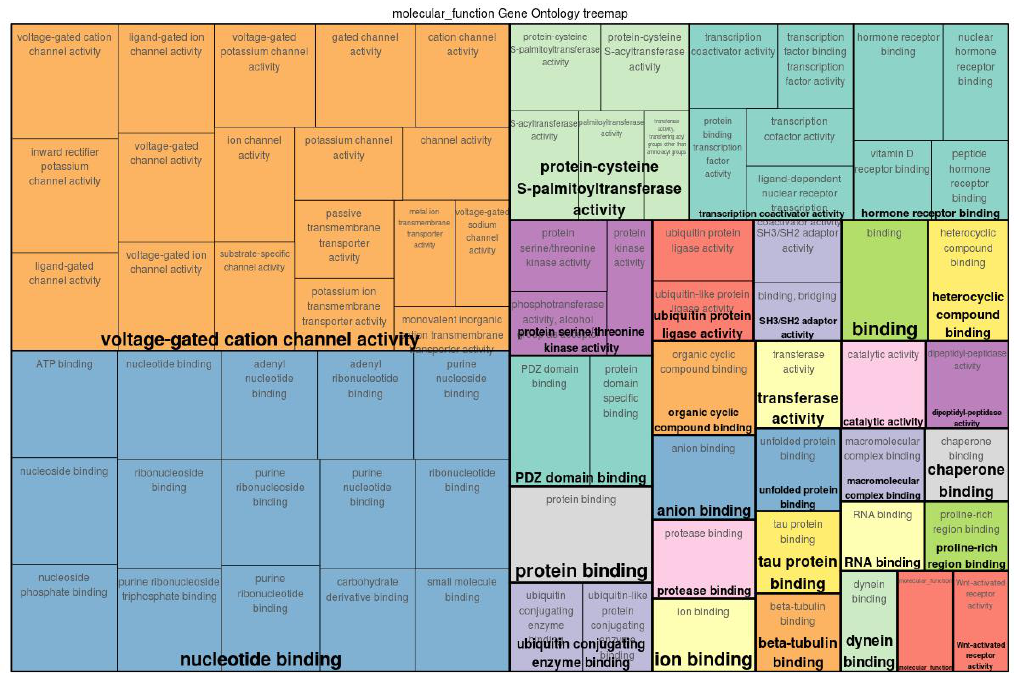
Figure 4. Gene Ontology (GO) treemap for genes associated with eggshell strength at Time Point 2 (ESS2). The boxes are grouped together based on the upper-hierarchy GO-term which is written in bold